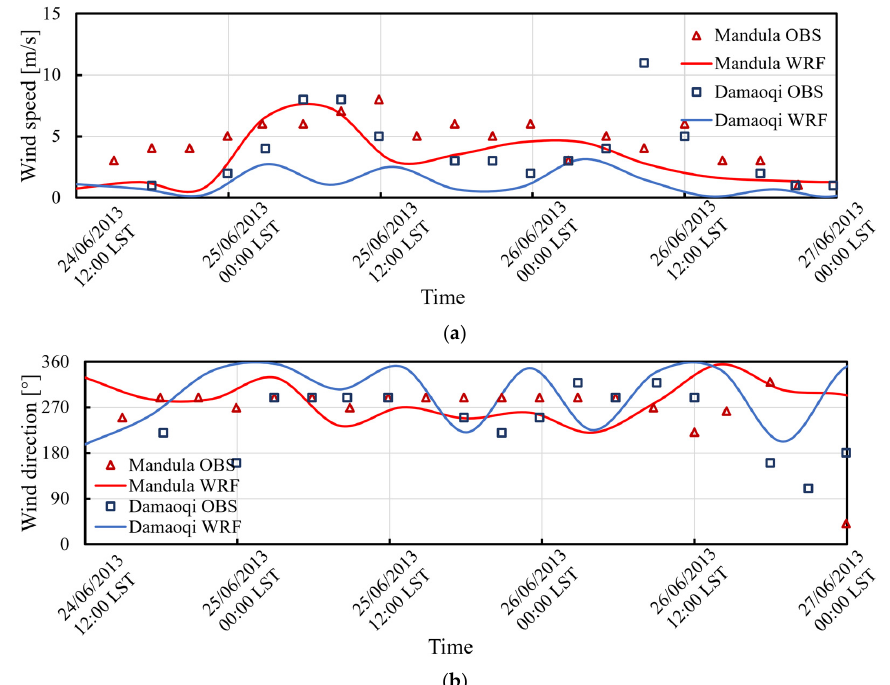
Figure 15. Variation of near-surface ( a ) wind speed and ( b ) wind direction above the main landing area from WRF and weather stations from 12:00 LST on 24 June 2013 to 00:00 LST on 27 June 2013.